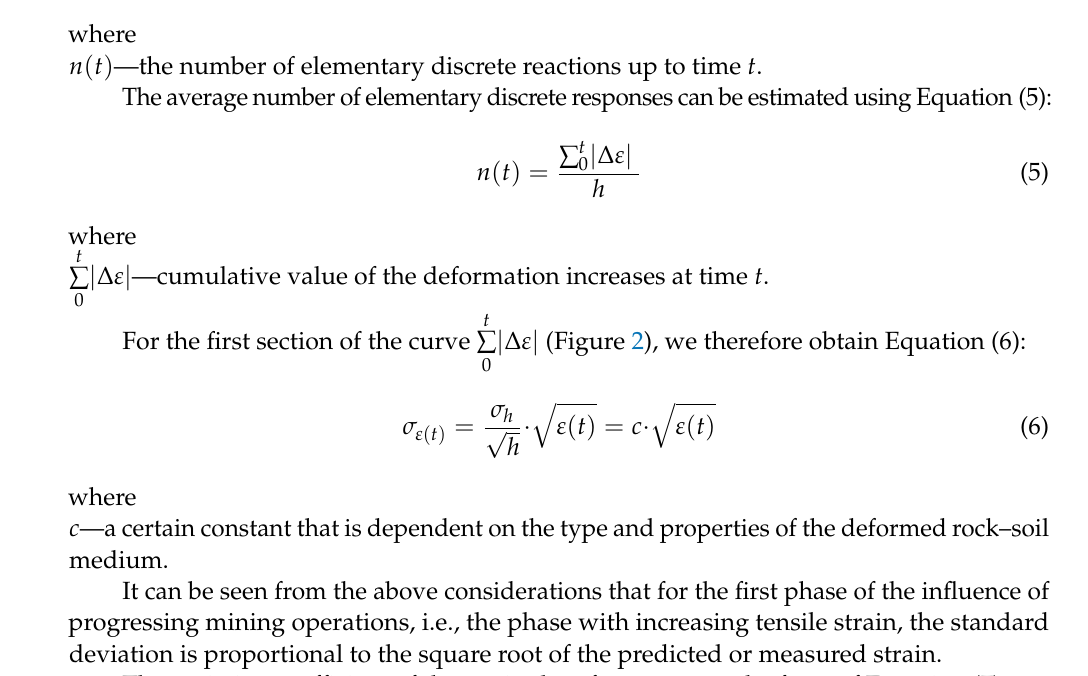
Figure 2. A schematic representation of deformation accumulation over time (own study).